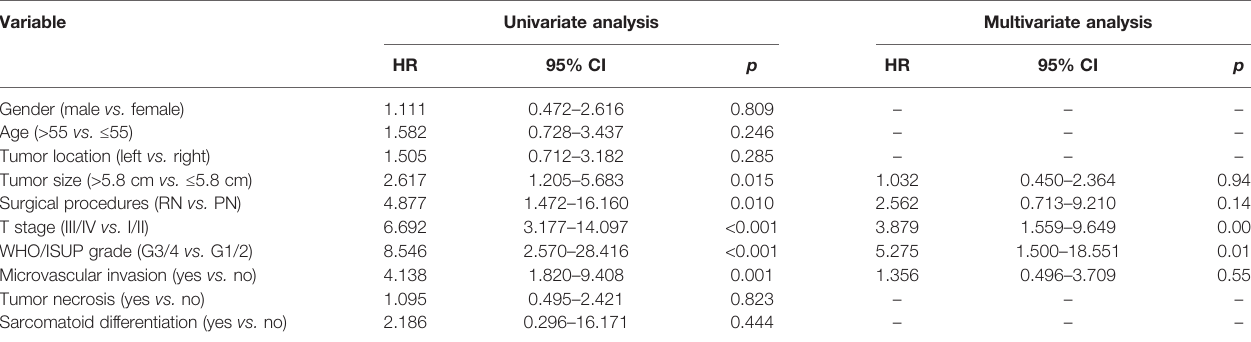
TABLE 2 | Univariate and multivariate Cox regression analyses of factors predictive of progression-free survival in type 2 PRCC patients. Variable Univariate analysis Multivariate analysis HR 95% CI p HR 95% CI p Gender (male vs. female) 1.111 Age (>55 vs. ≤ 55) Tumor location (left vs.